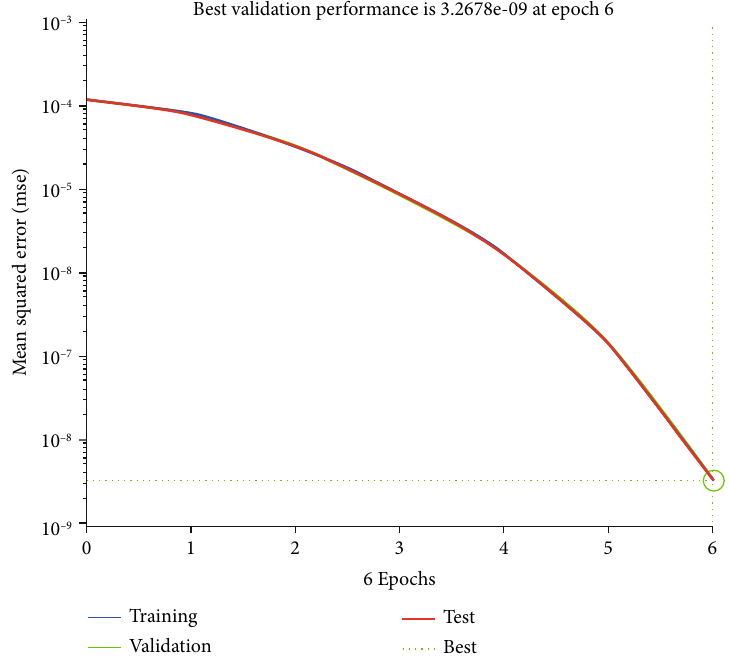
Figure 25: DNN-current regulator ’ s best validation performance.